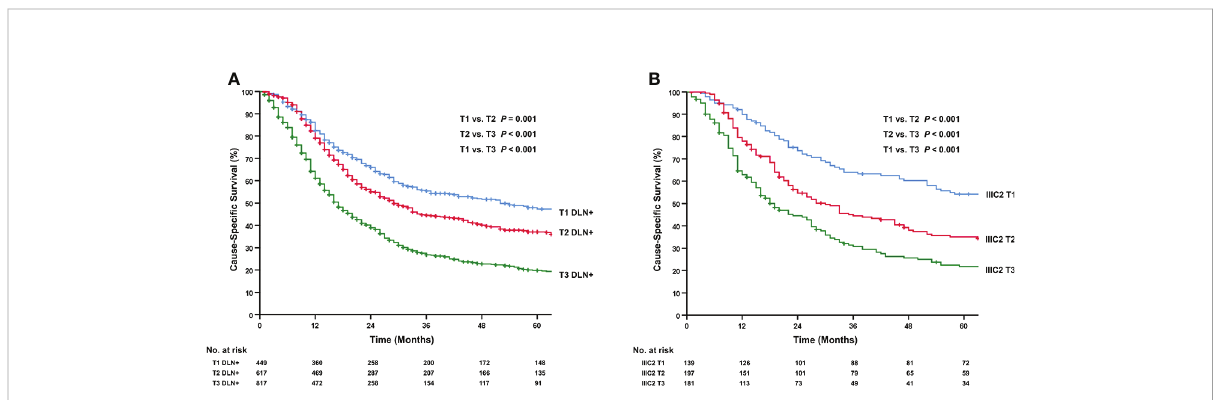
FIGURE 3 Kaplan-Meier curves for cervical cancer patients with distant lymph node metastasis based on different T stage. (A) DLN+ group (1988 – 2016). (B) stage IIIC2 (1988 – 2003). DLN+, positive distant lymph nodes. Trend analyses for two cohorts were signi fi cant. All P values had been adjusted by the Benjamini-Hochberg procedure and adjusted P <0.05 was considered statistically signi fi